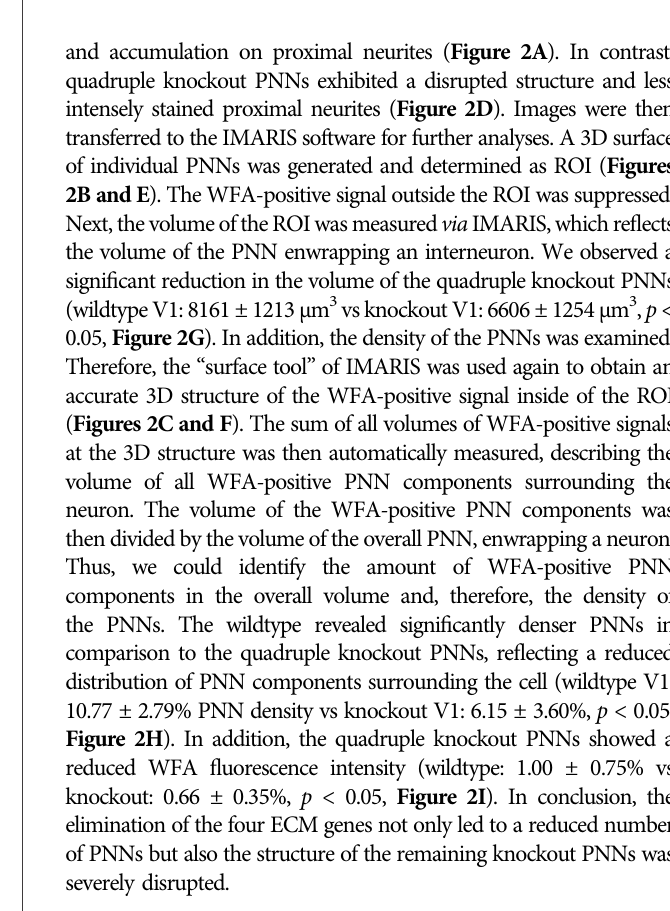
FIGURE1| total aggrecan immunoreactivitybetweenwildtypeand knockout; 4xKO, quadruple knockout; V1, primary visual cortex; WFA, Wisteria fl oribunda agglutinin; WT, wildtype, *** p < 0.001 data are shown as mean ± SEM and SD, scale bar A = 1000 μ m, scale bar B – E = 200 μ m, and scale bar J – M = 20